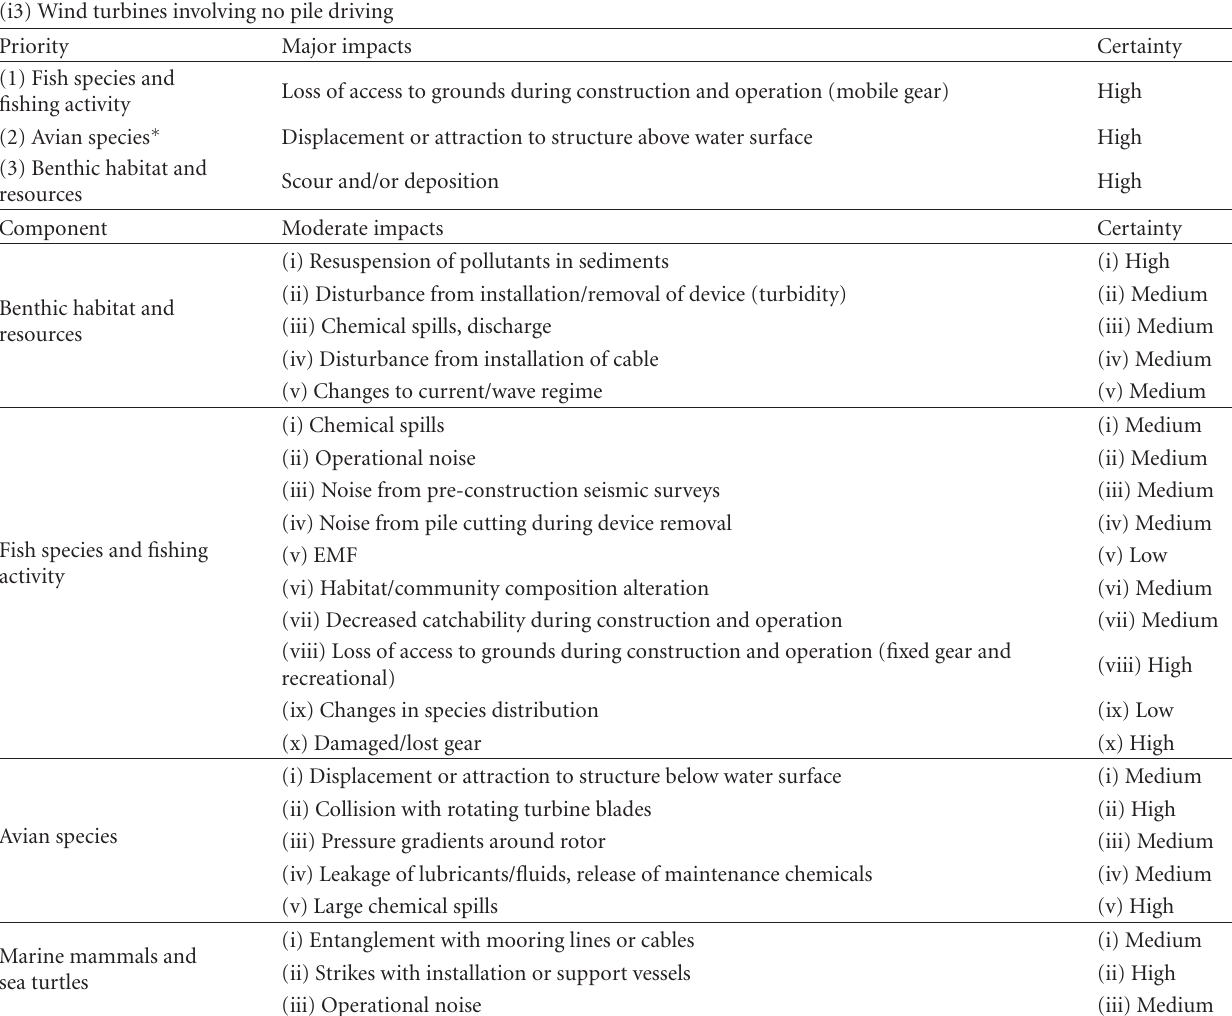
Table 5: A description of the potential impacts resulting from wind turbine projects involving no pile driving. See text, Section 3.3, for a narrative summary of this development scenario. Ecosystem components are ranked by their proportion of the major impacts. Moderate impacts are listed in the order they appear in the renewable energy impact